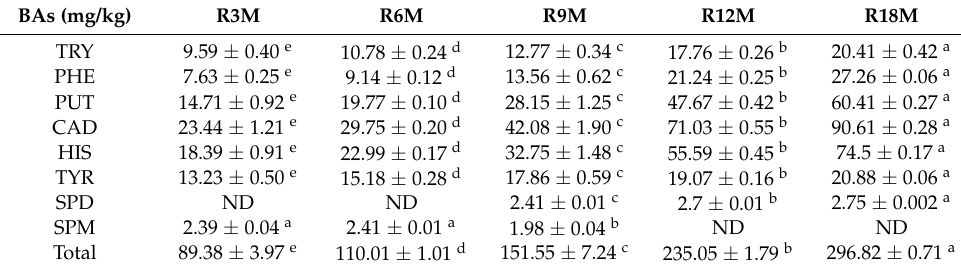
Table 1. Content of BAs in fish sauce samples at different fermentation